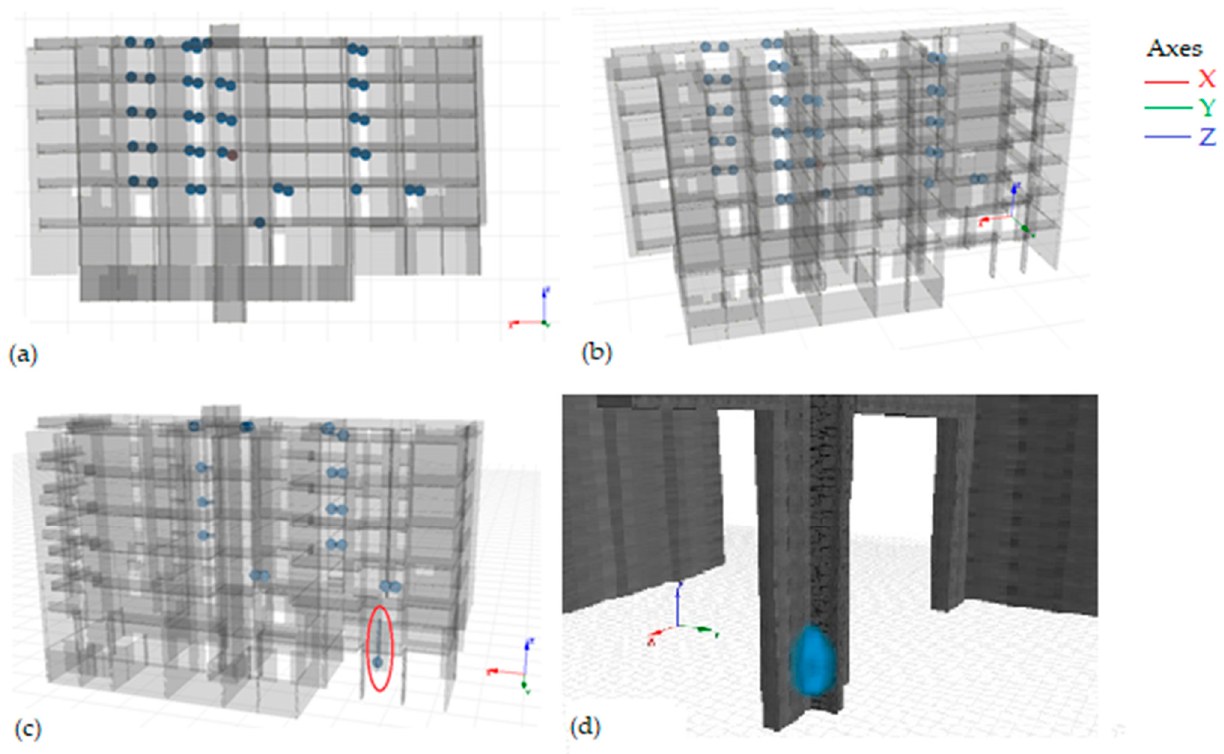
Figure 20. ( a , b ) Plastic hinges detected in the model during the non-linear dynamic analysis; ( c , d ) plastic hinge at the base of a weaker column on the right side of the building.